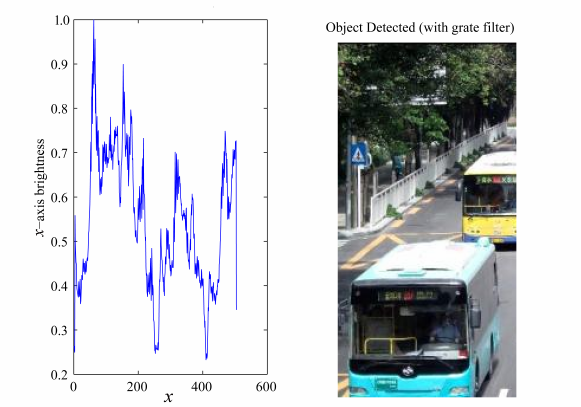
Fig. 15 Horizontal axis’ brightness values and selected cars (with grate filter) according to Fig.